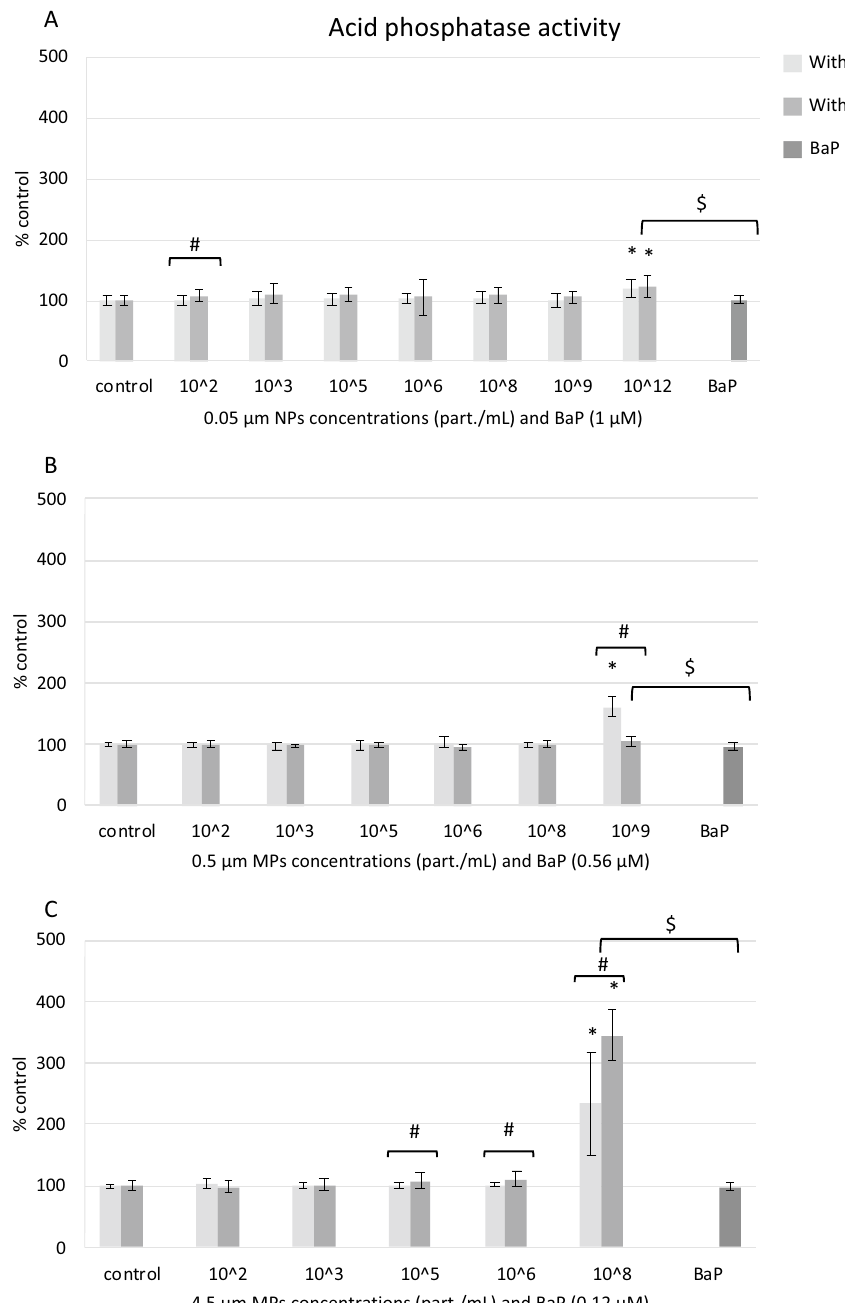
Figure 6. Lysosomal AcP activity in mussel hemocytes exposed for 24 h to ( A ) 0.05 µm NPs, ( B ) 0.5 µm MPs and ( C ) 4.5 µm MPs alone or in combination with BaP and to BaP alone. Data are given as percentages with respect to control ± SD (n = 18). * indicates significant differences with respect to controls, # indicates significant differences between NPs/MPs with or without BaP and $ indicates significant differences between NPs/MPs with BaP and BaP